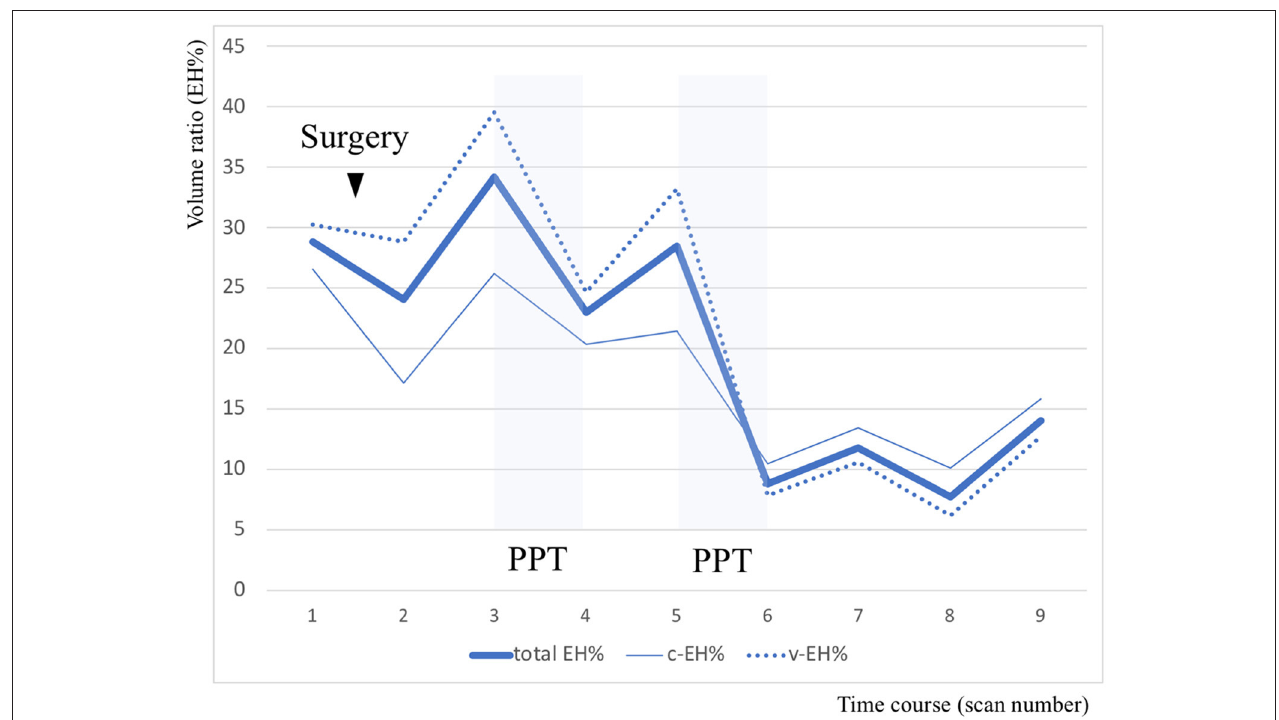
FIGURE 2 | Volume analysis of endolymphatic hydrops (EH) divided into cochlea and vestibule regions. The y axis indicates the volume ratio of EH to the involved part of the inner ear volume in the right ear. In this chart, the bold line indicates the volume ratio of EH relative to total inner ear volume (total EH%), the fine line indicates the volume ratio of EH relative to cochlear volume (c-EH%), and the dotted line indicates the volume ratio of EH relative to vestibular volume (v-EH%).